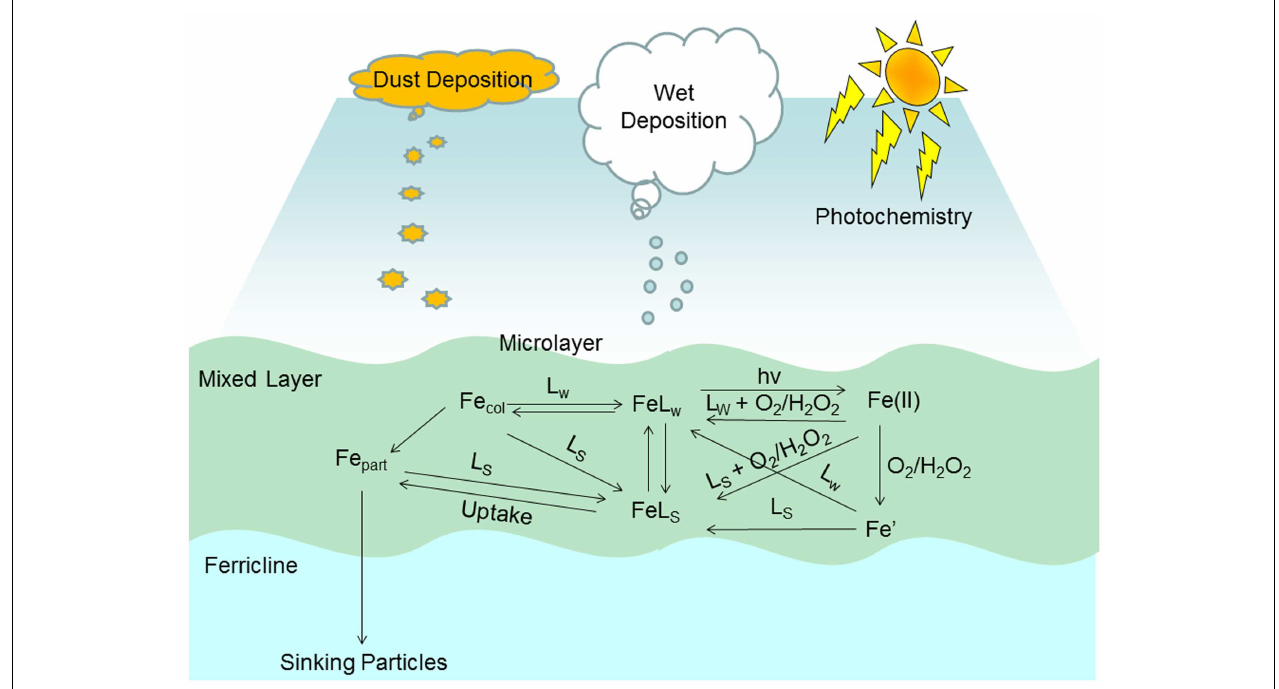
weak iron binding ligand; Fe(II), all sum of all Fe(II) species; Fe (cid:48) , the sum of all inorganic Fe(III) species; Fe col , colloidal iron species; Fe part , iron in the particulate phase; hv, photon flux; O 2 , dissolved oxygen; and H 2 O 2 , dissolved hydrogen